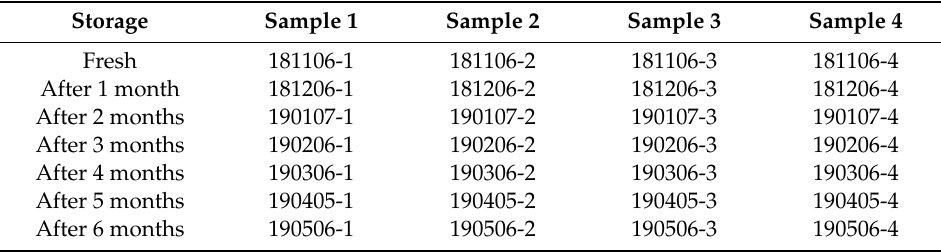
Table 3. Sample code for all four samples during 6 months of